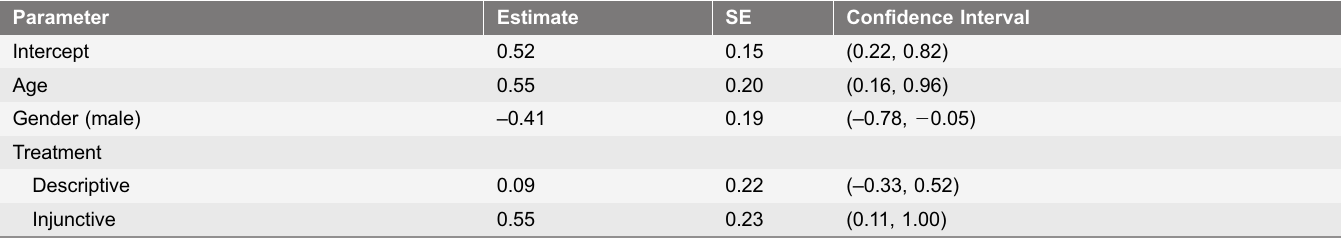
Table 1. GLM to investigate factors affecting probability that Player 1 would comply with the ‘give $0.20’ norm.